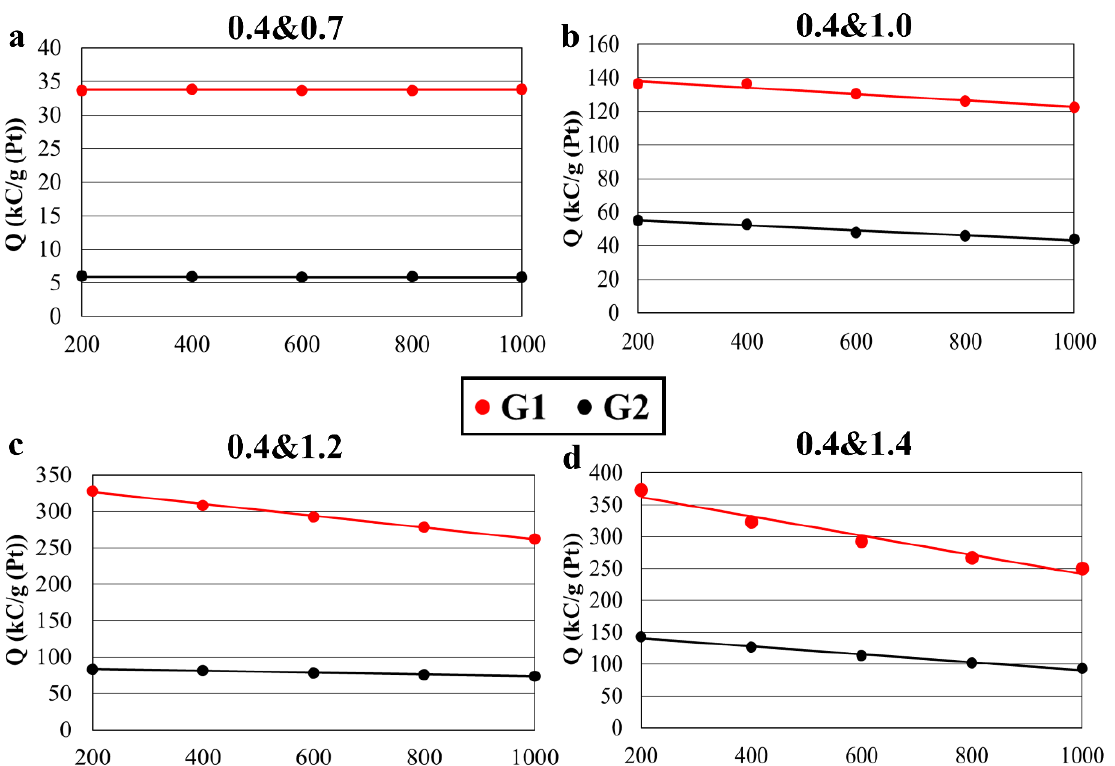
Figure 9. Diagrams of the amount of electricity passed for every 200 cycles during the entire stress test to different ADT protocols: ( a ) 0.4 and 0.7 V; ( b ) 0.4 and 1.0 V; ( c ) 0.4 and 1.2 V; and ( d ) 0.4 and 1.4 V.